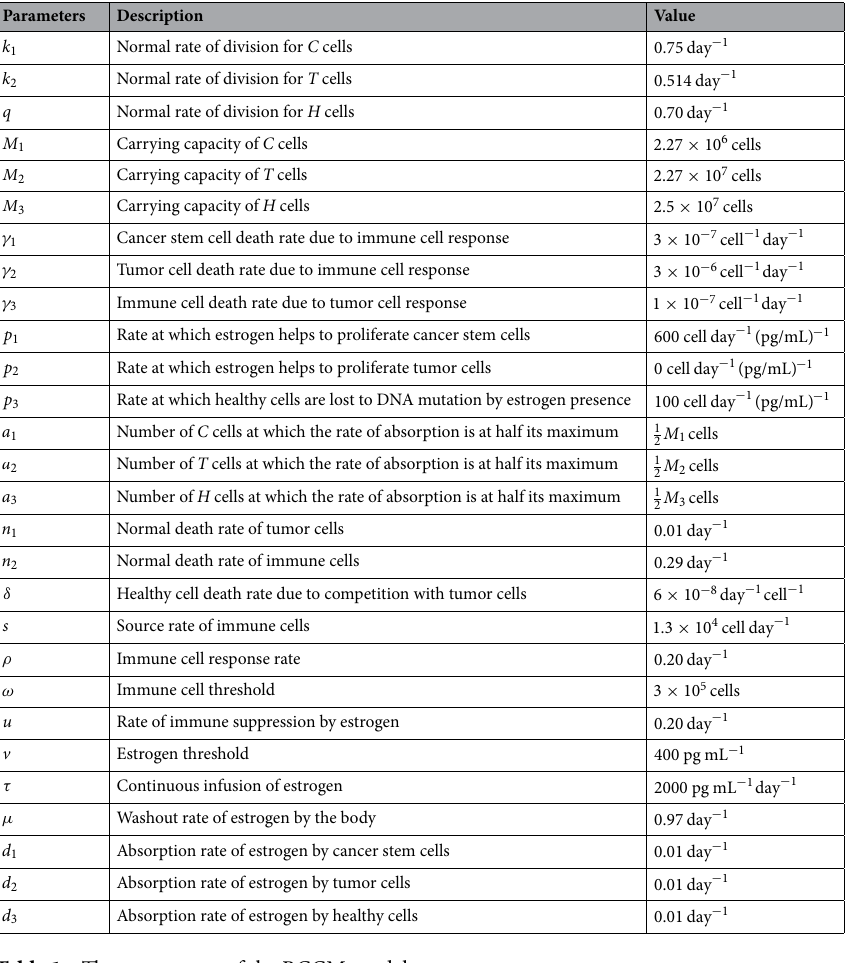
Table 1. The parameters of the BCCM